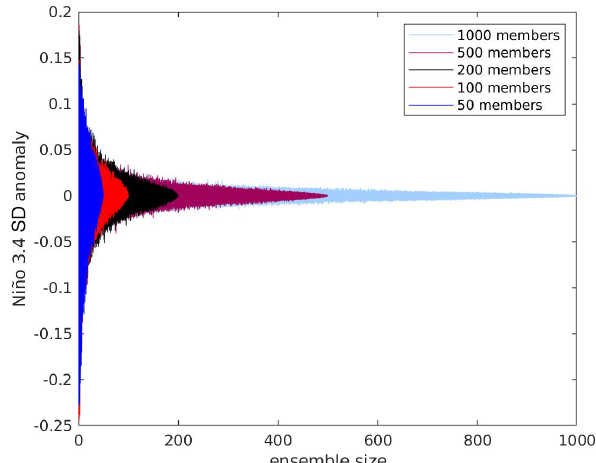
Figure A3. Probability density function (PDF) of ensemble-averaged Niño3.4 standard deviations possible in the MPI-GE pre-industrial control simulation for subsampling ensembles ranging from 50 to 1000 members (shown as different colours) for smaller ensemble sizes. Each PDF is shown relative to the corresponding ensemble mean value. We use the last 1000 years of the 2000-year control run to calculate the ranges. The Niño3.4 standard deviation is calculated over 50-year periods. The PDFs are created by resampling the control simulation 1000 times. For each PDF the entirety of the 1000 years is used (i.e. the blue 500-member PDF is the mean of two 500-member